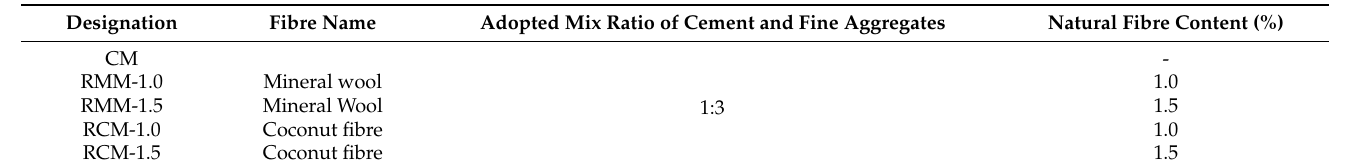
Figure 3. Hardened mortar samples.